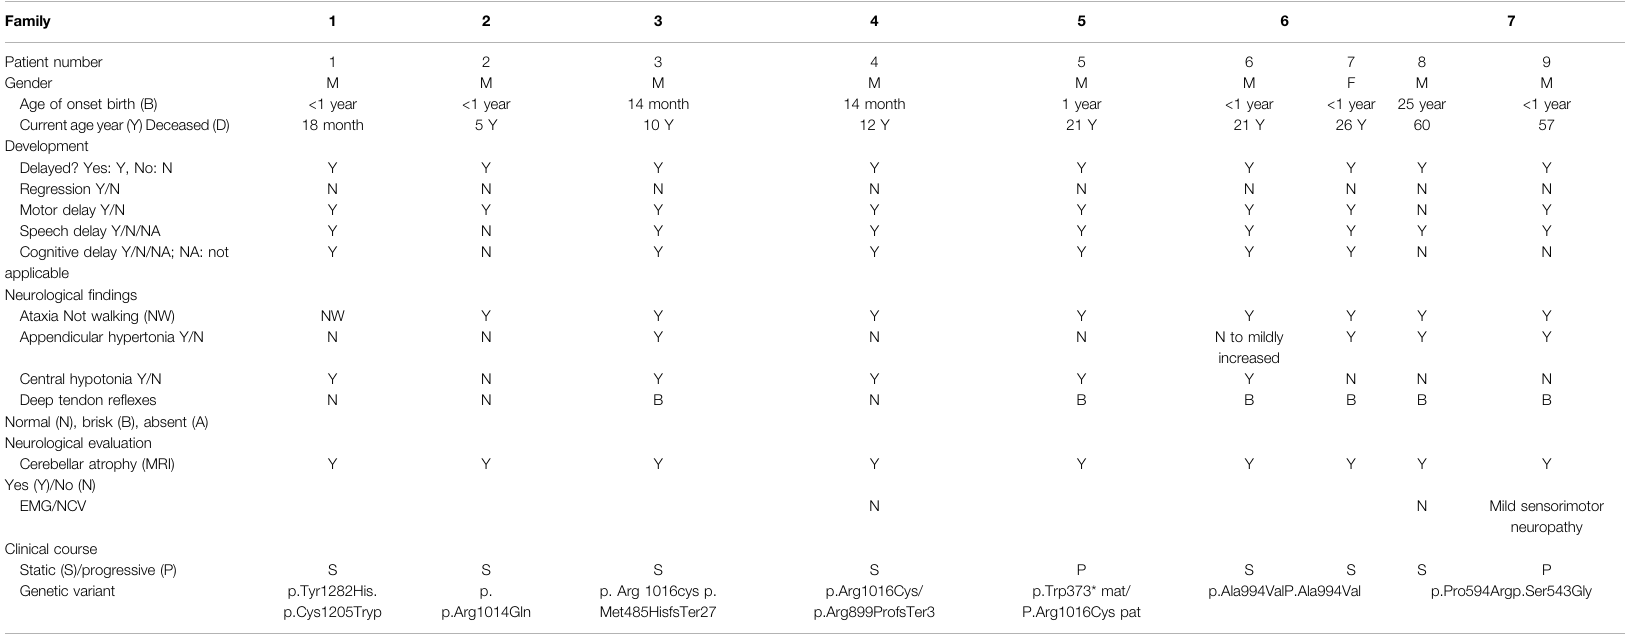
TABLE 1 | Clinical presentations in patients with biallelic variants in GEMIN5. Family